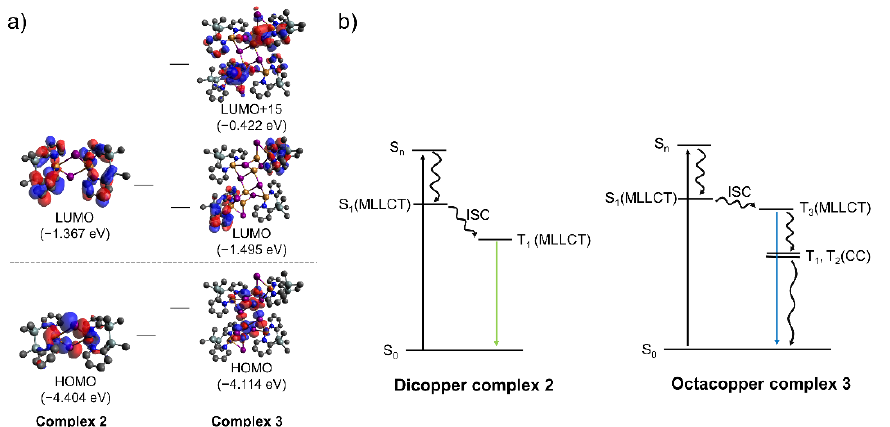
Figure 4. ( a ) Representative molecular orbitals and energy levels of 2 and 3 related to electronic transitions. ( b ) Plausible luminescent mechanisms of 2 and 3 at room temperature. Wavy lines indicate the nonradiative relaxation